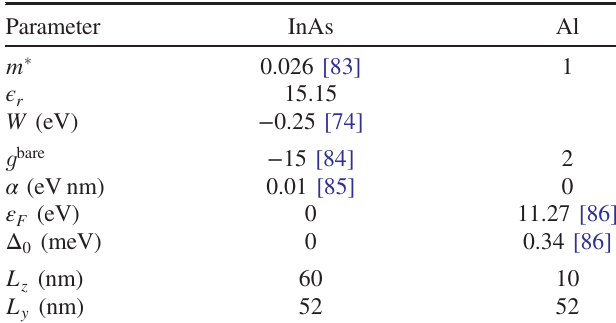
TABLE I. Physical parameters for InAs and